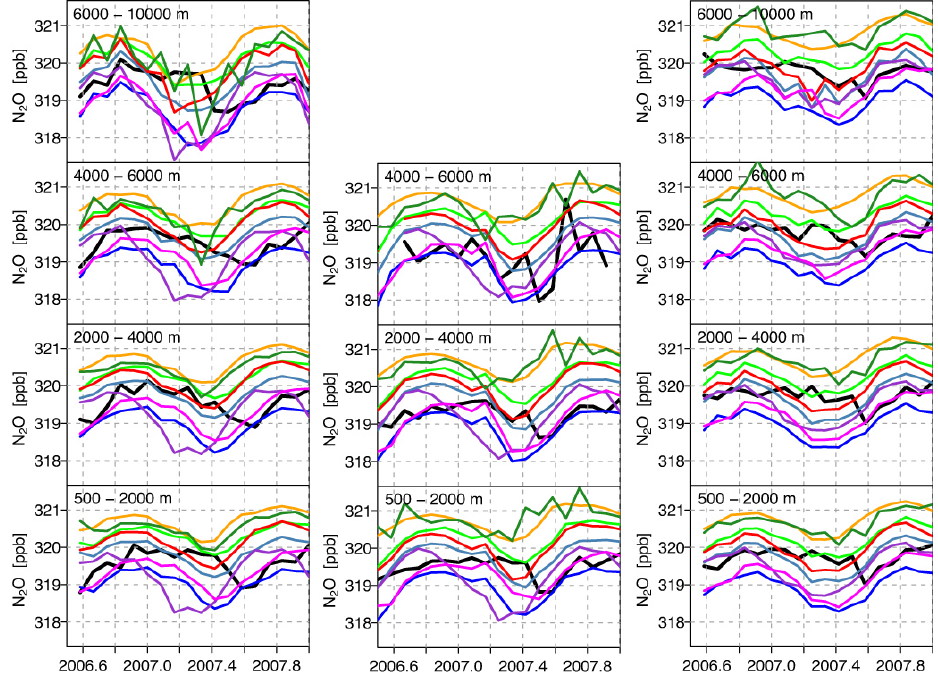
Fig. 9. Comparison of N 2 O at different altitudes (along the rows) at the aircraft sampling sites: PFA (left panel), ULB (middle panel; no data were available for altitudes above 6000 m) and HAA (right panel). Data are shown as monthly means with the growth rates (as given in Table 6) subtracted. MOZART4 was adjusted with an offset of − 1ppb to fit the N 2 O scale. Legend: Mozart4, yellow; ACTMt42l32,